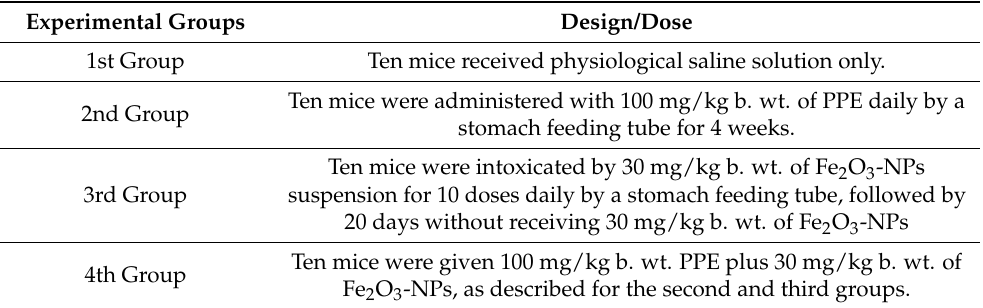
Table 1. Experimental design for different groups. Experimental